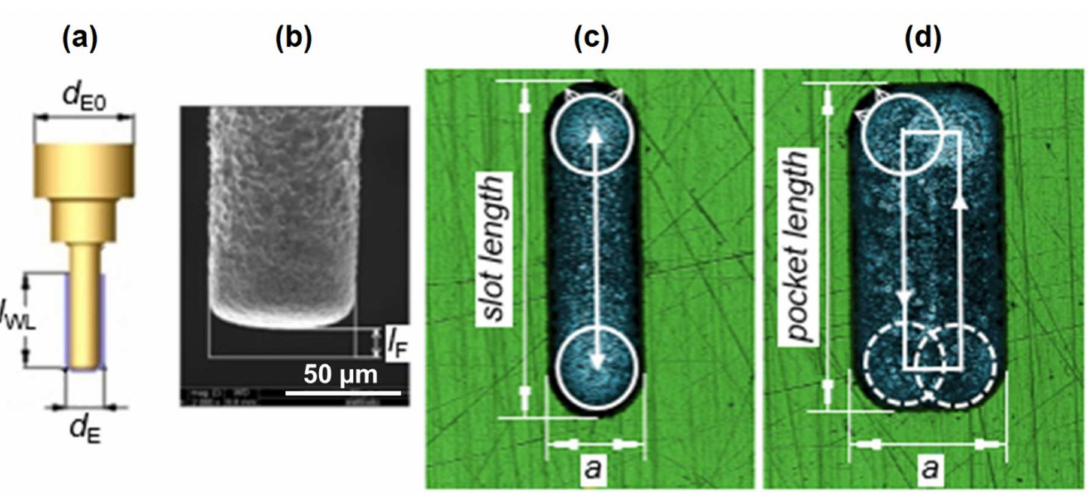
Figure 4. ( a ) Schematic presentation of the dressed electrode used for micro EDM milling with its main features: d E0 —diameter of primary electrode, d E —electrode working diameter, l WL —electrode working length. ( b ) A scanning electron microscope (FEI Quanta 400, FEI, Hillsboro, Ore., USA) image of a worn electrode where l F denotes linear wear. ( c ) A confocal microscope image (Sensofar PL µ , NEOX, Sensofar Medical, Terrassa, Spain) of a groove ( a = 90 µ m) presenting slotting strategy for machining. The white circles represent the cross-section of the electrode and the arrows at the circle’s circumference denote the sparking gap. ( d ) Presentation of pocketing strategy for machining of a pocket groove in 2 passes ( a = 140 µ